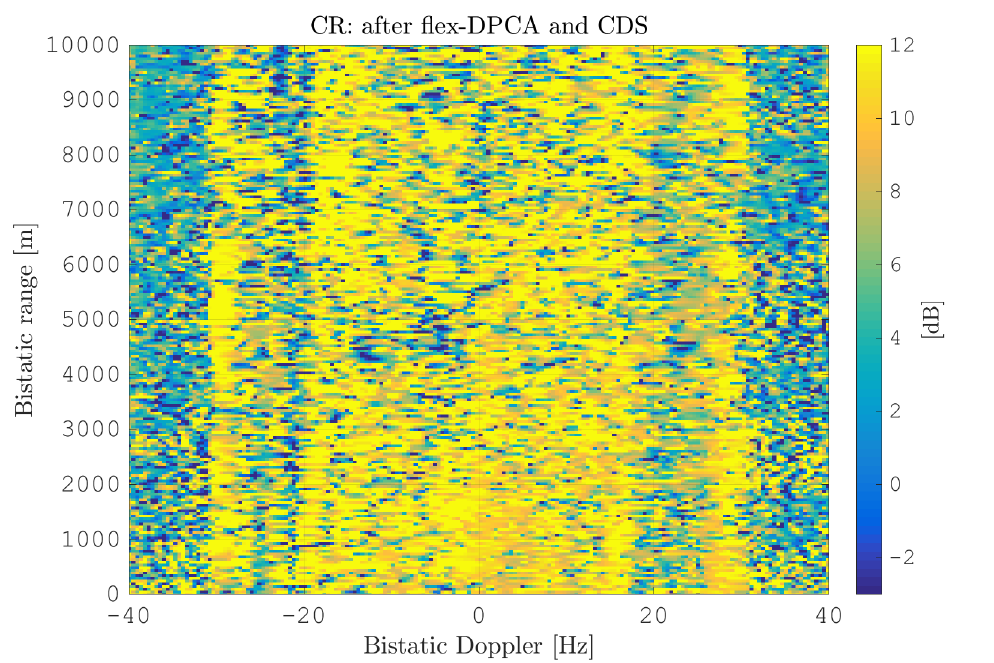
Figure 15. Cancellation ratio between range-Doppler maps after DPCA application: after flex-DPCA (Figure 12) and CDS (Figure